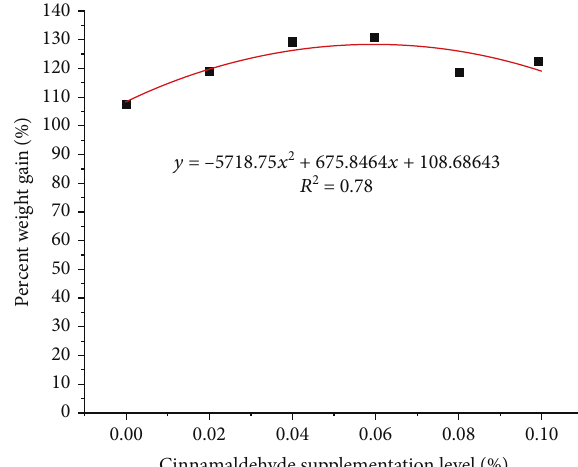
Figure 1: Curve chart about the relationship between the cinnamaldehyde supplementation level (%, X ) and percent weight gain (%, Y ) in juvenile H . otakii for 8